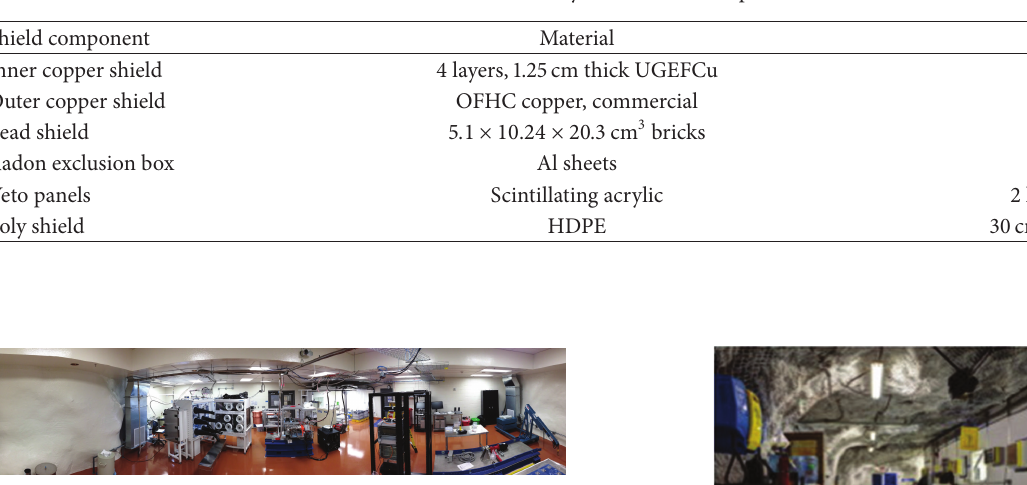
Figure 11: A view of the detector laboratory at the Davis Campus at SURF. In this view, the glove box is to the left, and the prototype module is at the center. In the rear, a soft-wall cleanroom is shown that serves the purpose of an area of increased cleanliness.